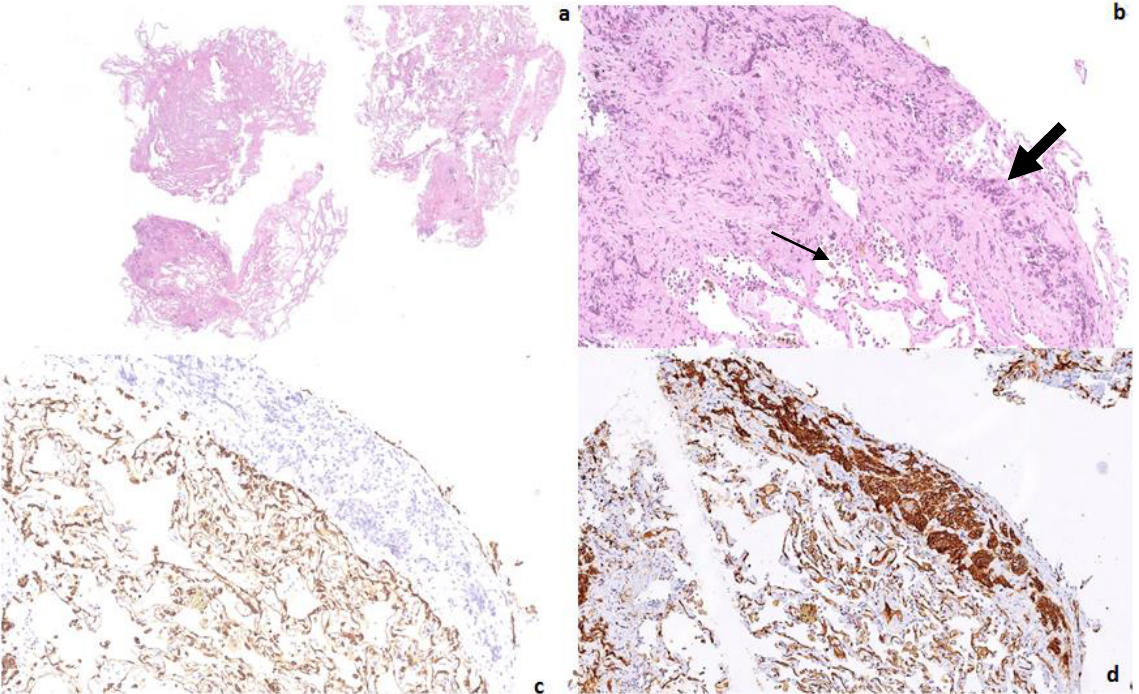
Figure 2. Transbronchial lung biopsy specimen revealed fragments of lung parenchyma characterized by subacute and fibrosing interstitial lung damage associated with chronic hemorrhagic lung injury (small arrow). Low and high-power magnifications demonstrated an interstitial and endovascular infiltration (large arrow) of epithelioid shaped cells, respectively, (( a , b ) hematoxylin-eosin X2 and X13). The epithelioid cells resulted negative ( c ) for pancytokeratin (clone AE1-3 X13), and were strongly immunoreactive ( d ) for CD31 (X 12,5). Pulmonary hemangioendothelioma (PEH) was diagnosed; the patient was referred to a specialized Oncology Unit but died 10 months later. In almost all PEHs, a characteristic t(1;3) (p36; q23 – 25) translocation leading to a WWTR1-